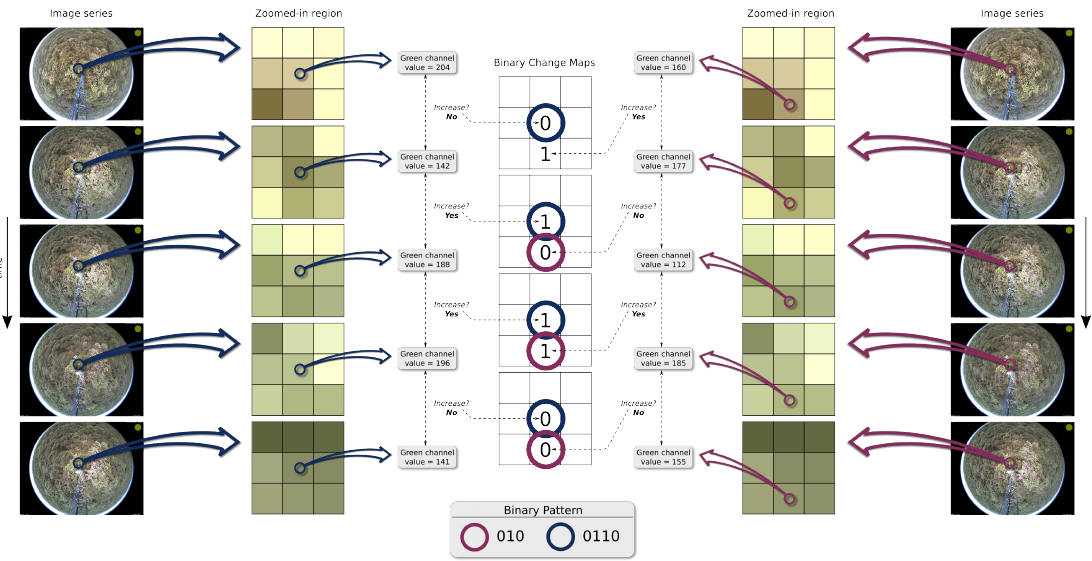
Figure 2. Example of the detection of the 010 and 0110 binary patterns using a series of typical phenological images. Both sides of the figure show the same image series and zoomed-in regions (i.e., the same location in each image). For illustration purposes, the analysis is done only for two pixels from the focused region. Nevertheless, the complete procedure requires the analysis of all image pixels. After a “training” step, a new set of images taken in a different time period but from the same area can be used to test the foveal models and their extracted sROIs. Images can be taken as a set of sparse points, or be reconstructed by several methods (e.g., voronoi diagrams, quad-trees) that provide a 2-d space-variant representation. From that, data can be extracted and processed (e.g., phenological visual rhythms and interest-point/statistical descriptors). By using space-variant images, memory storage may be reduced given some image are represented at different resolutions and contain less